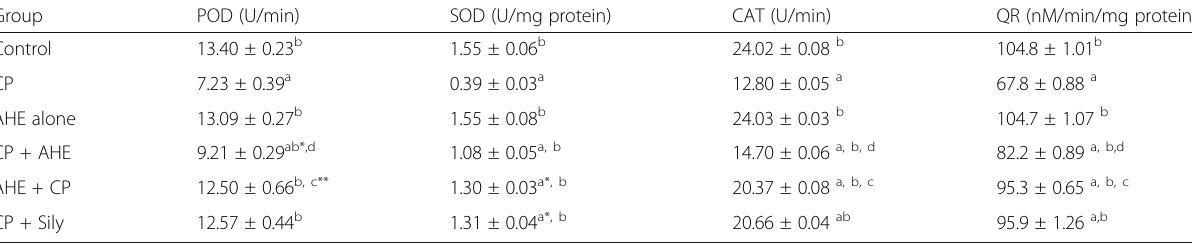
Values expressed as mean ± SEM a Significance at p < 0.0001 Vs. control group b Significance at p < 0.0001 Vs. Cisplatin (CP) group c Significance at p < 0.0001 of AHE + CP pre-treated group Vs. CP + AHE post-treated group d Significance at p < 0.0001 of CP + AHE treatment groups Vs CP + Sily group *,** Significant difference at p < 0.001. Non-significant difference ( p > 0.05) was recorded between control and AHE alone treated group in all parameters (One